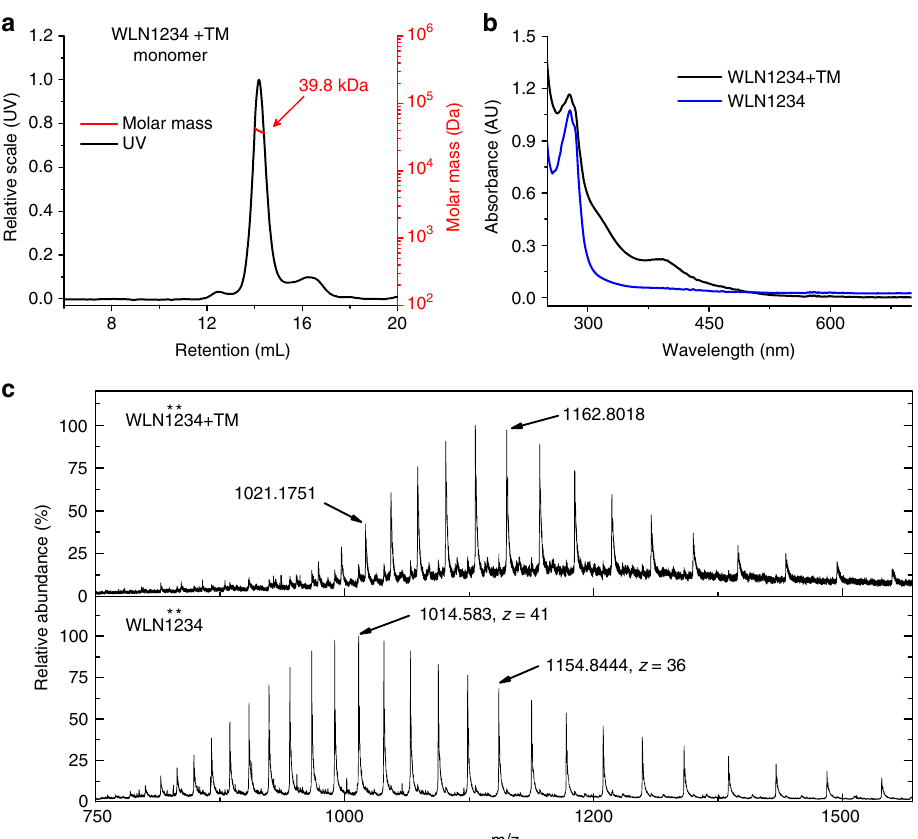
Fig. 5 TM induces intramolecular crosslink of MBDs in WLN. a SEC-MALS analysis of the monomeric fraction obtained from the reaction of WLN1234 with TM. b UV – Vis measurement of WLN1234 and the monomeric adduct from the reaction with TM. c ESI-MS spectra of WLN1234 before (low portion) and after (up portion) the reaction with TM. A protein mutant of WLN1234 (Cys-to-Ser mutation on domains 1 and 2, MW 41541.07 Da) was used in ESI-MS analysis. Multiple peaks are present due to differently charged signals. The m / z of two representative peaks ( + 41 and + 36 charged) are